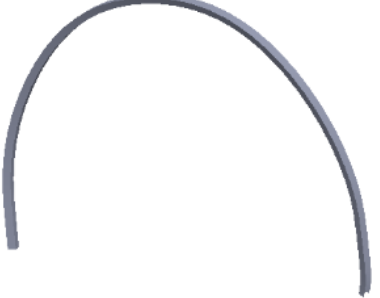
Figure 7. Arch yielding support geometry.